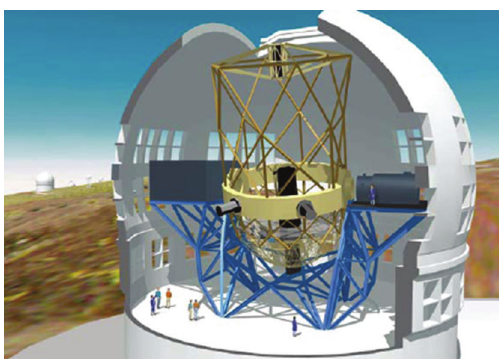
Figure 11: The Spanish 10.4 m GTC telescope in La Palma, Canary Islands. Courtesy of